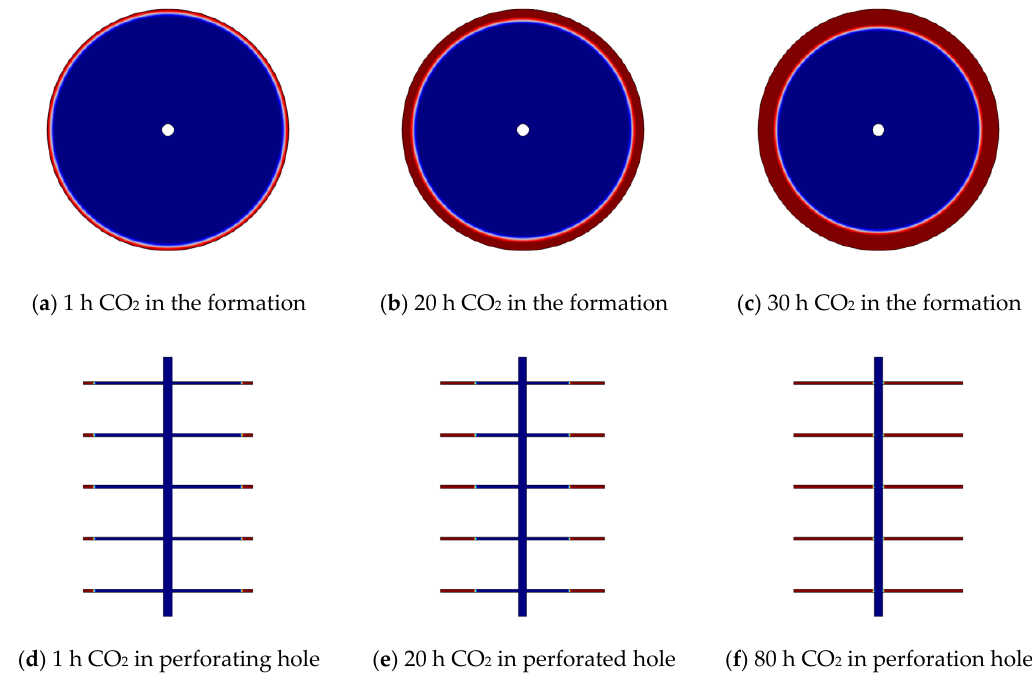
Figure 3. Diffusion process of CO 2 in wellbore and formation.